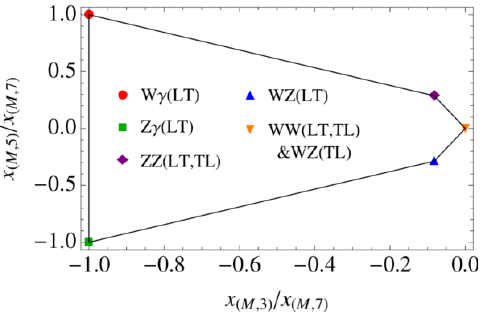
Figure 12 . The 5 rows in M M only involve three parameters: (cid:0) 2 F M; 1 + F M; 7 , F M; 3 and F M; 5 . The corresponding ~x i vectors have 3 components. The plot shows the intersection points P i = ( x =x ; x =x ) of ~x i on the plane x i; ( M; 3) i; ( M; 7) i; ( M; 5) i; ( M; 7) a convex